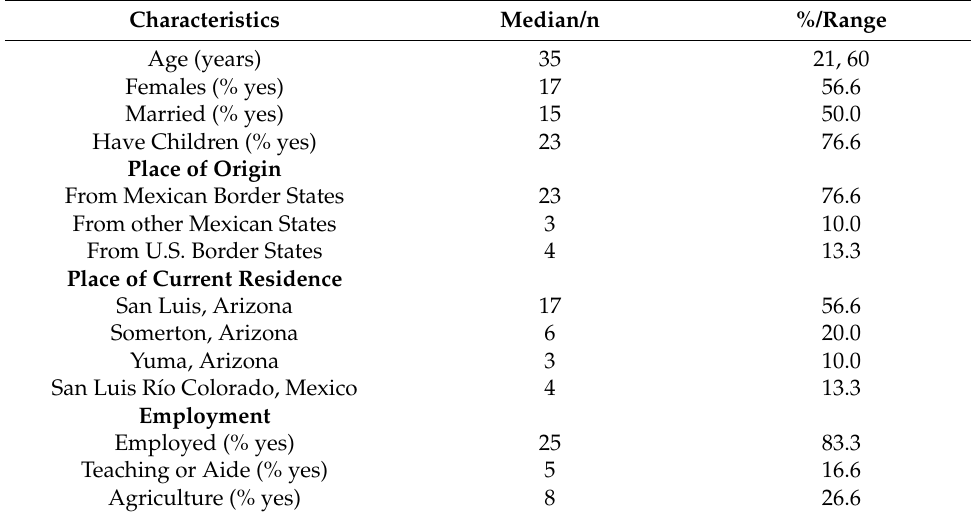
Table 1. Characteristics of Mexican Origin Study